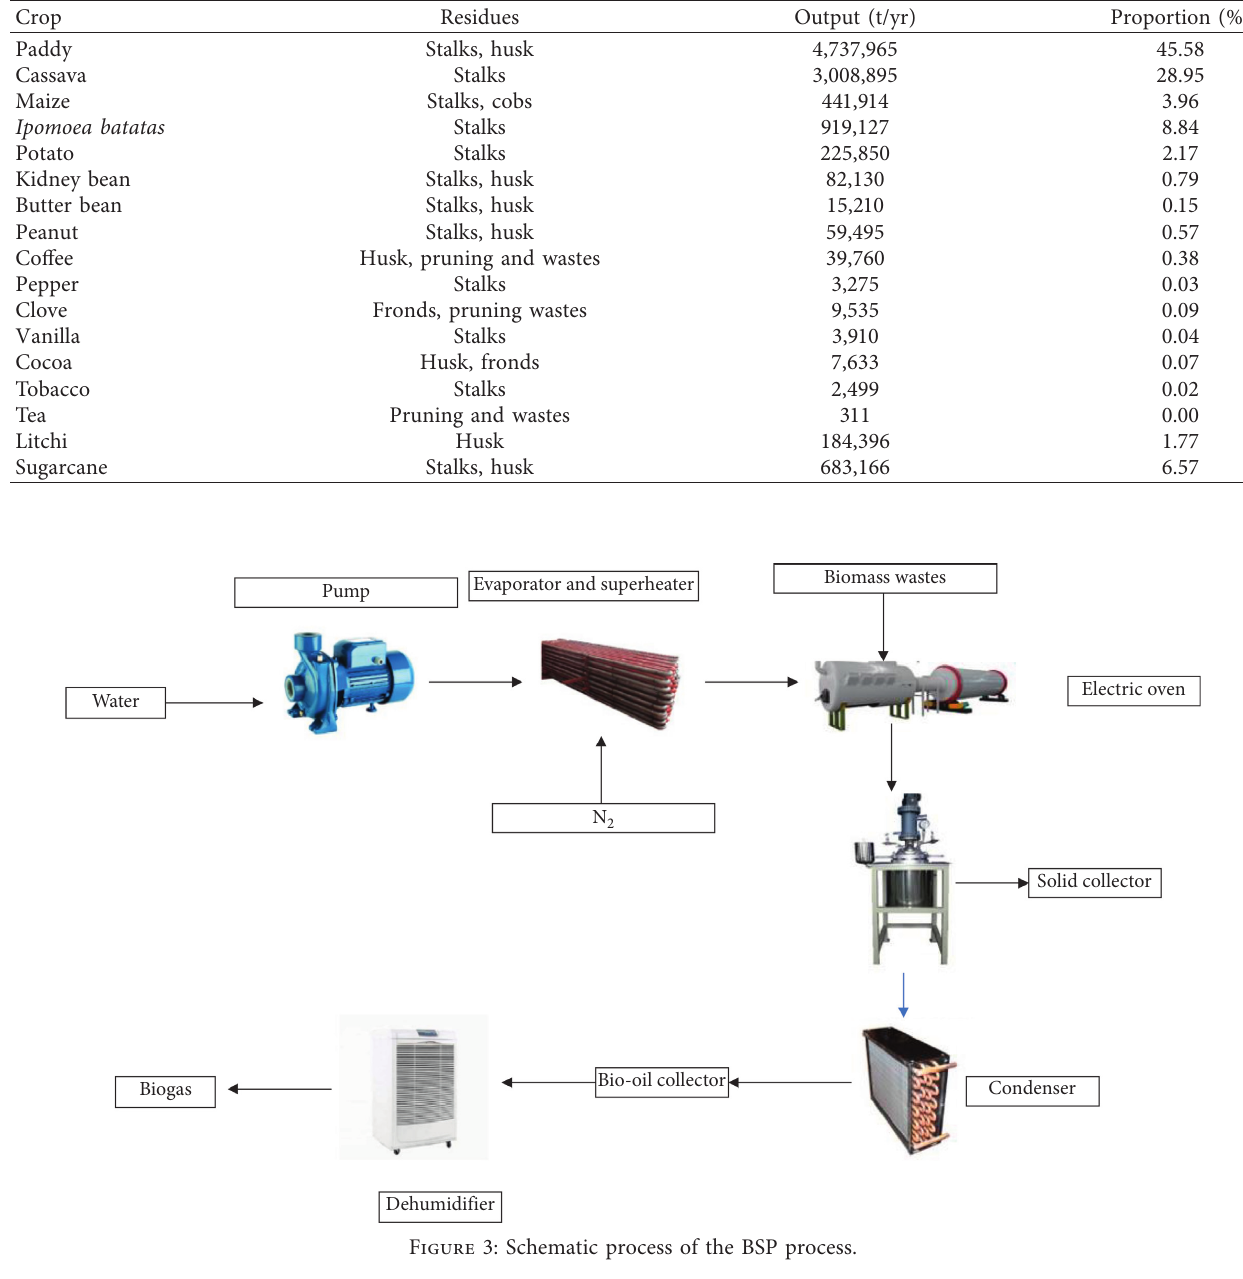
Table 1: Available farming residues for biomass energy generation in Madagascar.